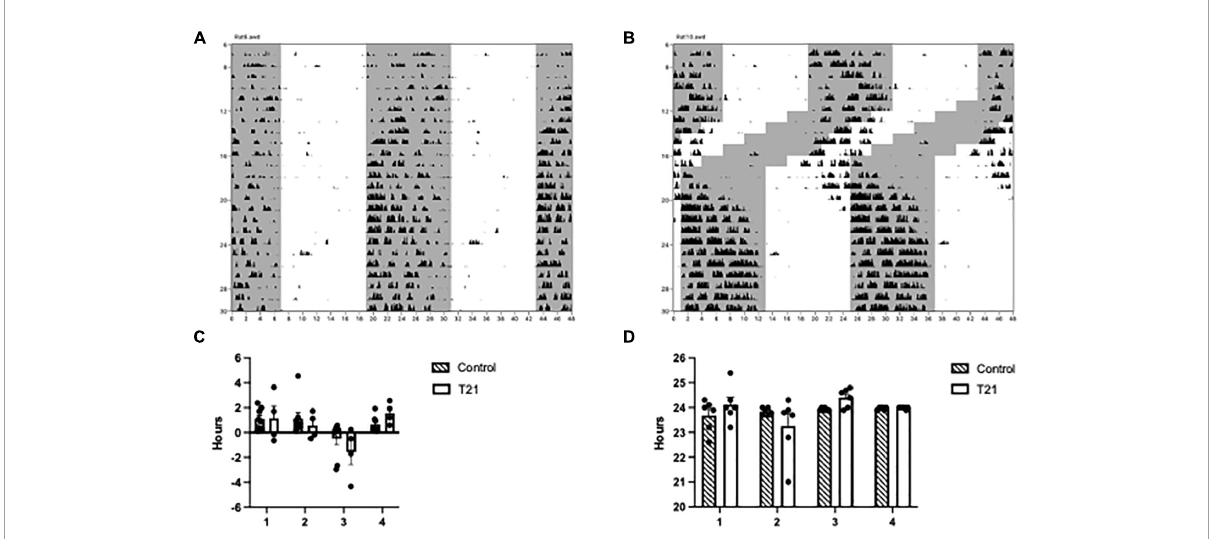
FIGURE2 Circadian rhythmicity throughout the experiment. (A) Actogram of a control rat throughout the experiment. The gray shaded region represents the portion of the LD cycle when the lights were off. (B) Actogram of a T21 rat throughout the experiment. (C) Average phase, or time elapsed between lights off and the onset of activity ( ± SEM) between groups prior to, during and following the T21. A block is equal to 6 days and a negative phase indicates that the activity onset occurred before lights off. (D) The average period ( ± ) of circadian rhythms between groups prior to, during, and following the T21.